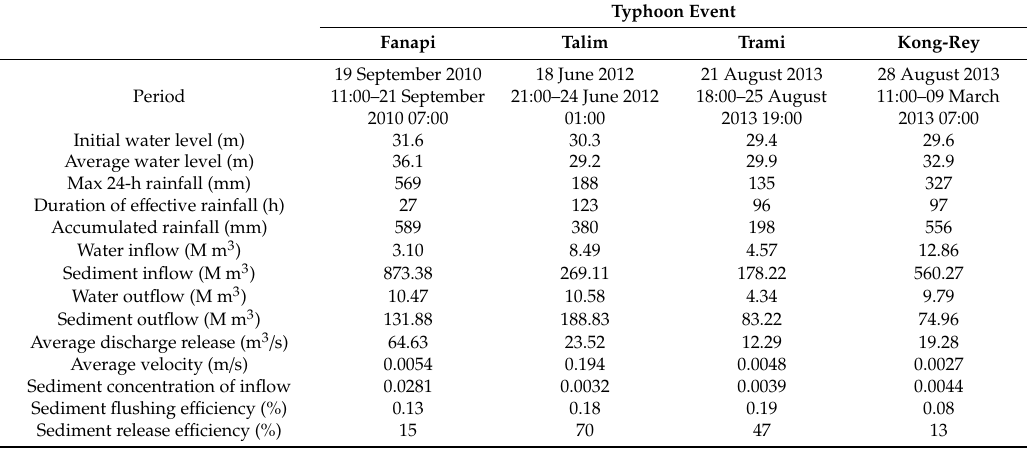
Table 2. Characteristics of the four selected typhoon events used for the simulation.